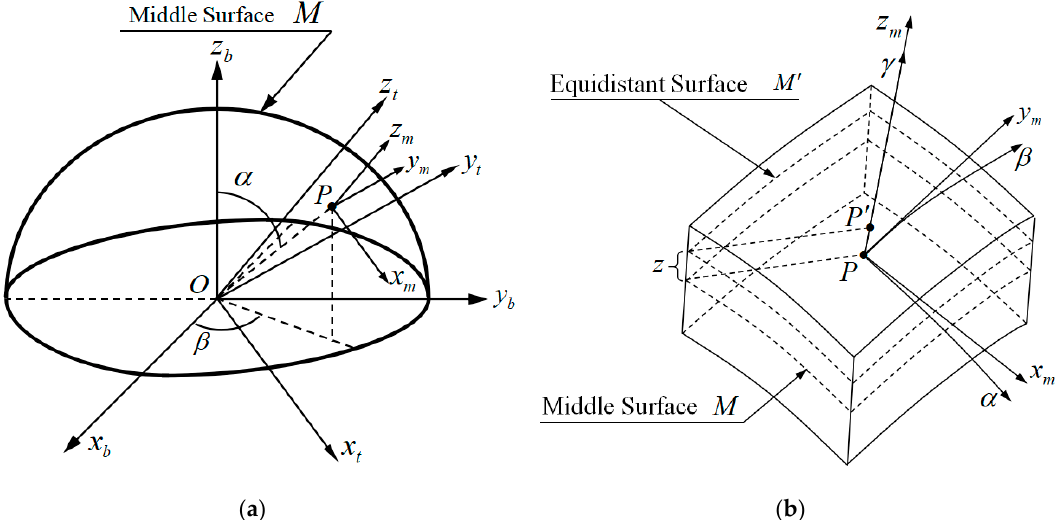
Figure 1. Middle surface, equidistant surface and corresponding coordinate systems: ( a ) Middle surface M of hemispherical shell and corresponding coordinate systems; and, ( b ) Equidistant Surface M′ of hemispherical shell and corresponding coordinate systems.